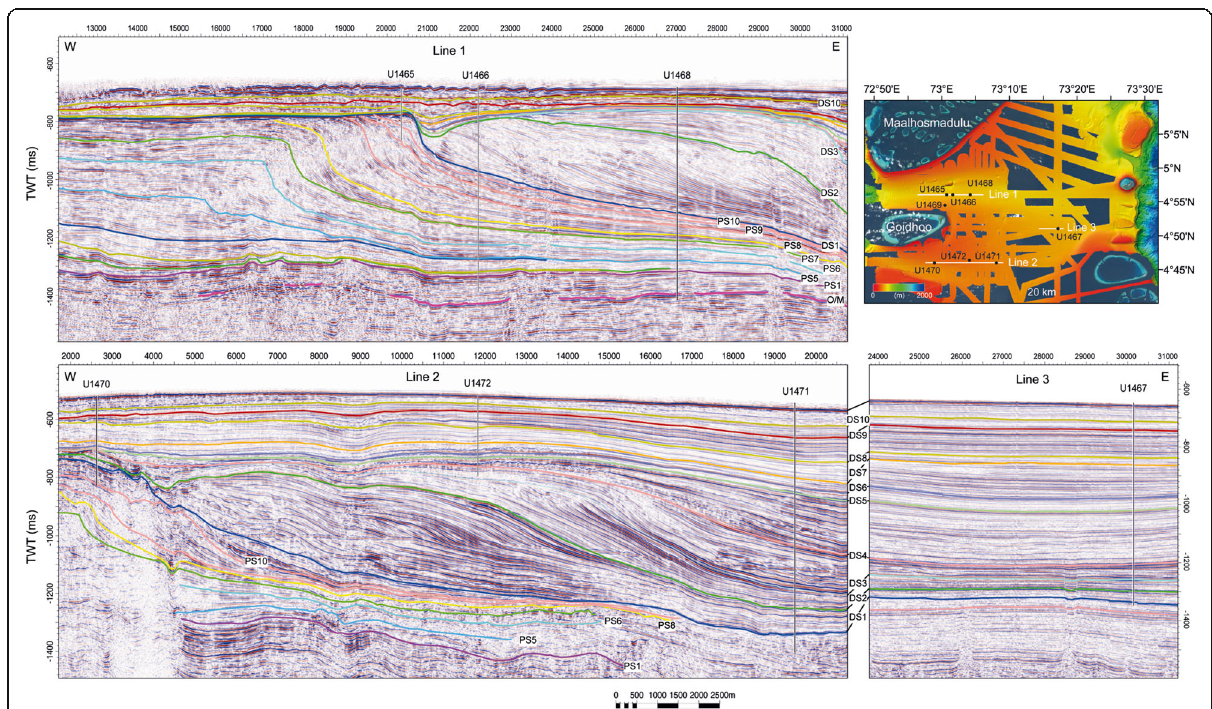
Fig. 3 Seismic lines with locations of IODP Exp. 359 sites and positions of sequence boundaries. Platform deposits and drift deposits are seismically well-resolved and are based upon their differing geometries, with a convex down shape characteristic of the platform clinoforms and a convex up shape characteristic of the drift deposits. Note that the position of Site U1472 is projected onto the seismic